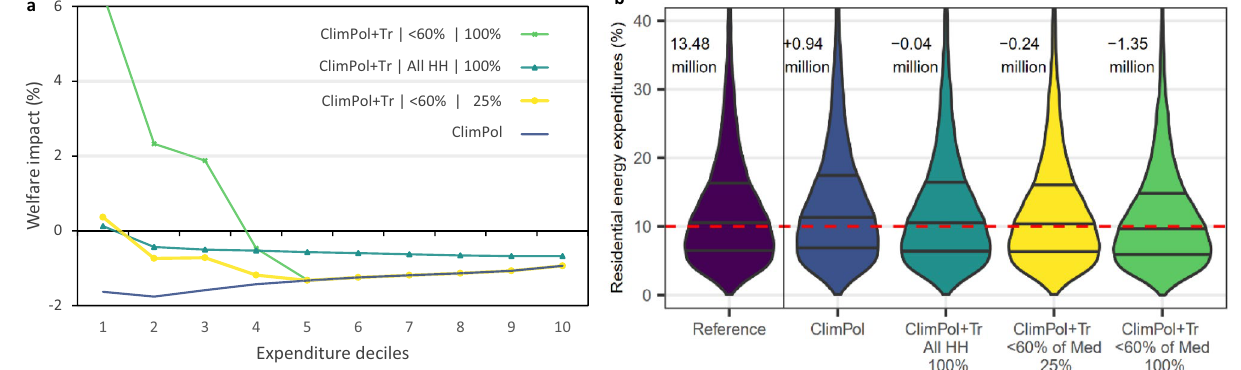
Figure 3. Distributional and energy poverty implications of strengthening climate action. ( a ) Welfare impacts across different expenditure deciles and scenarios (see main text). The welfare metric used is compensating variation expressed as a percent of total expenditures. ( b ) The violin plots show the distribution of the share of residential energy expenditures in total income for the households in the EU below the poverty line of 60% of median income in the respective country. Dashed red line indicates the cut-off point of 10% used to calculate the energy poverty indicator. Numbers depicted in the upper part of the chart indicate the change in the number of households in the EU in energy poverty due to climate policy and revenue recycling schemes relative to the Reference value of 13.48 million households in energy poverty. Reference refers to the situation under current policies; ClimPol introduces additional climate policy including the extension of EU ETS to buildings; ClimPol + Tr considers additional climate policy as well as lump-sum transfer recycling of (100% or 25% of) the additional tax revenue to (all or poor) households. Source: Own analysis based on the JRC-GEM-E3 model and the EU Household Budget